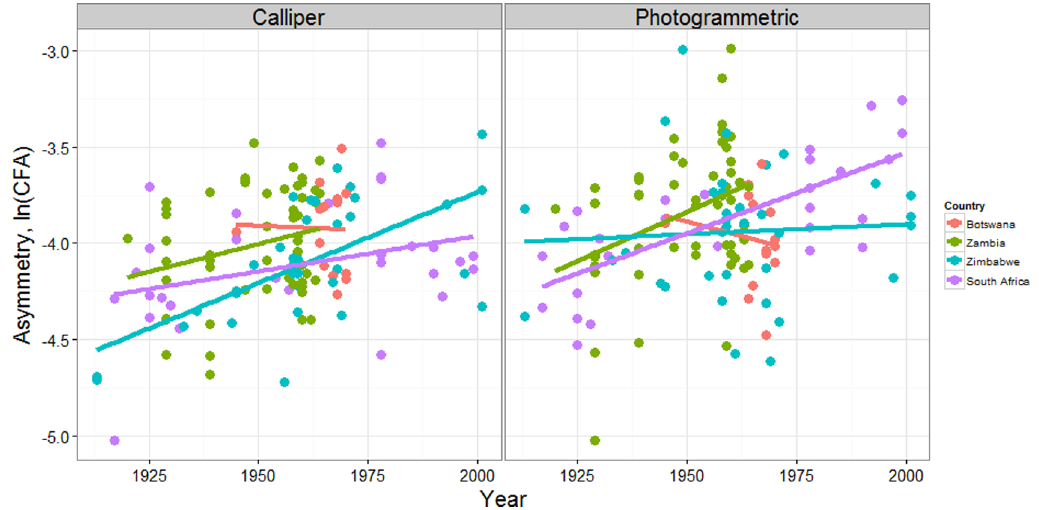
Figure 2. Fluctuating asymmetry ln(CFA) over time for calliper and photogrammetric measurements, with linear regression lines shown for each